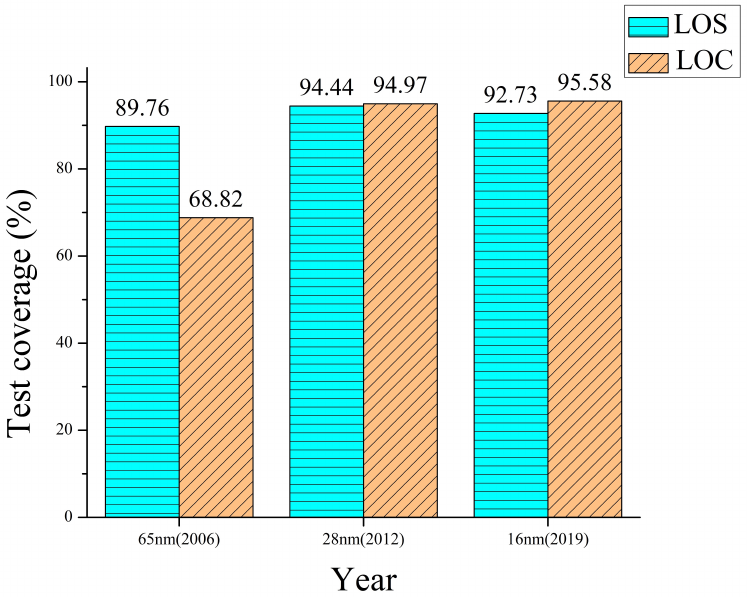
Figure 3. Result comparison of LOC and LOS based test coverage (commercial ATPG tool) with the evolution of years